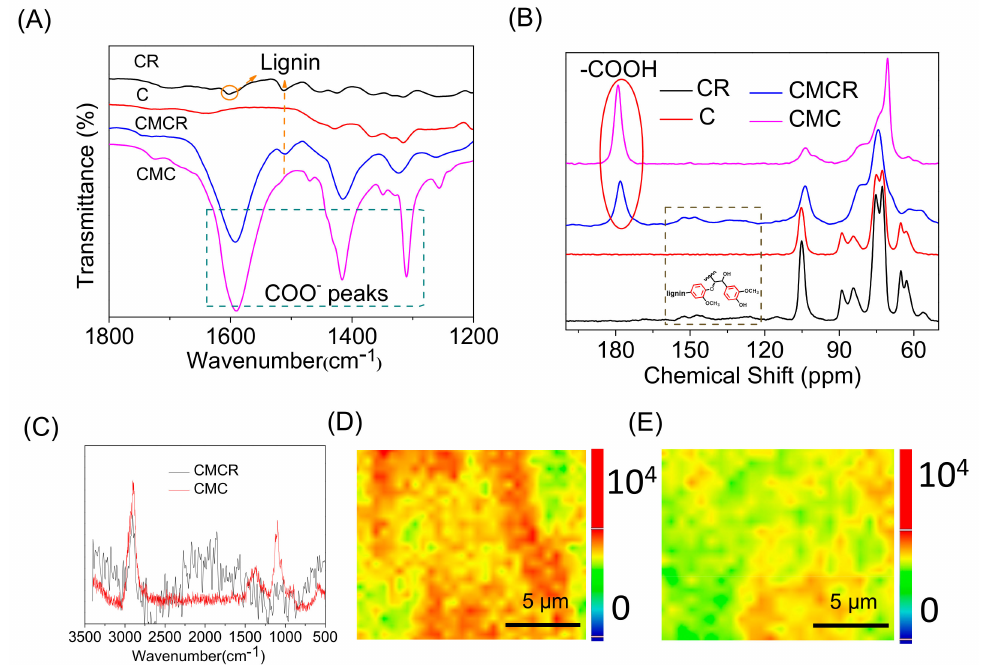
Figure 1. ( A ) FTIR spectra of CR (corncob residue), C (bleached cellulose), CMCR (carboxymethylated corncob residue), and CMC (carboxymethylated bleached cellulose) in the region 1800–1200 cm − 1 ; ( B ) 13 C CPMAS NMR spectra of four samples; ( C ) Raman spectrum; and reconstructed Raman mapping of CMC ( D ) and CMCR ( E ) using –COOH as an indicator. The deep red spot corresponds to high intensity, whereas the blue spot indicates weak